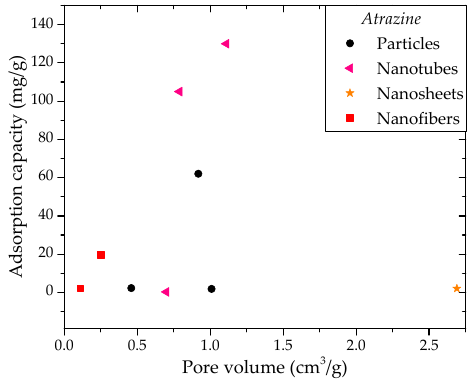
Figure 3. Adsorption capacity (mg/g) related to the adsorbent pore volume against Atrazine.